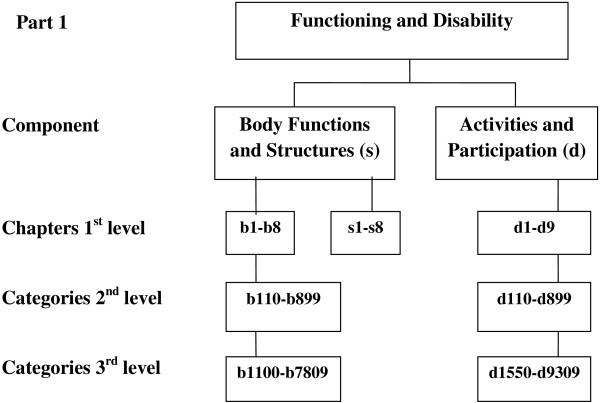
Structure of part 1 of the international classification of functioning, disability and health (icf) applicable to patients after total hip arthroplasty.